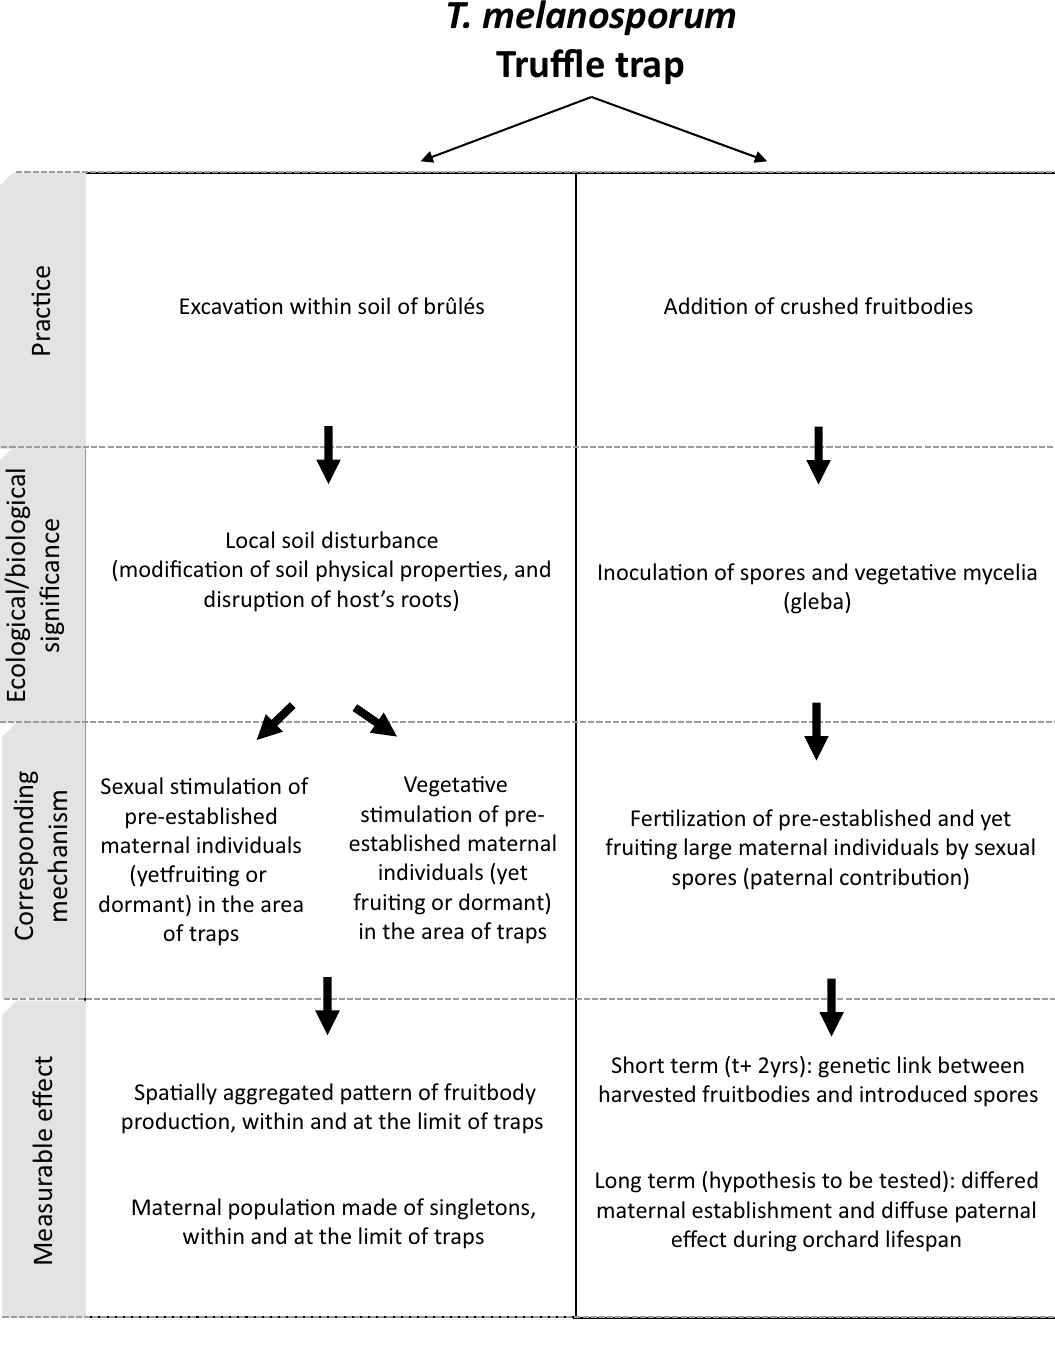
Figure 4. Diagrammatic representation of the mechanisms involved and measurable effects of truffle traps on T. melanosporum fruitbody